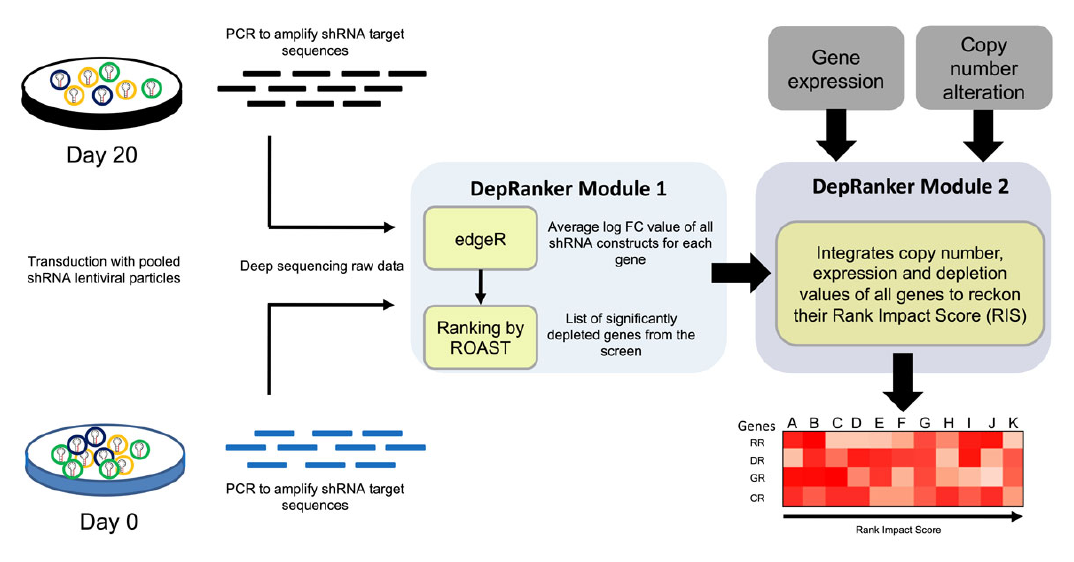
Figure S1: Schematic outline depicting the DepRanker, an automated tool to identify driver genes from pooled functional genomic screens. CR = copy number alteration rank; DR = depletion rank; FC = fold change; GR = gene expression rank; RR = ROAST